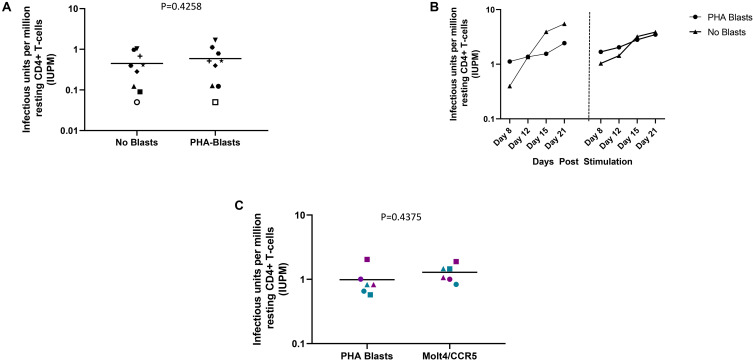
DEVO assay outcome using either no blasts, or PHA blasts or the HIV permissive cell line, Molt4/CCR5 to expand virus. (A) Increase in IUPM values over time in cultures receiving either PHA blasts or no exogenous targets (no blasts). Two independent assays using cells from two participants are shown (left and right panel, DV-01 and DV-02). (B) Similar IUPM values are obtained in the DEVO assay whether or not exogenous targets to expand virus are used. Each symbol represents an independent assay performed with cells from distinct participants. (C) The HIV permissible cell line Molt4/CCR5 expands virus as well as PHA blasts in the DEVO assay. Results from independent assays performed with cells from three different participants (DV-01, DV-05 and DV-06) at day 8 (green) and day 12 (purple) are shown. For each experiment, cultures either received Molt4/CCR5 or PHA blasts to expand virus. Each symbol represents a participant. Open symbols indicate values below the limit of detection. Wilcoxon matched-pairs signed rank test was used to compare statistical differences.